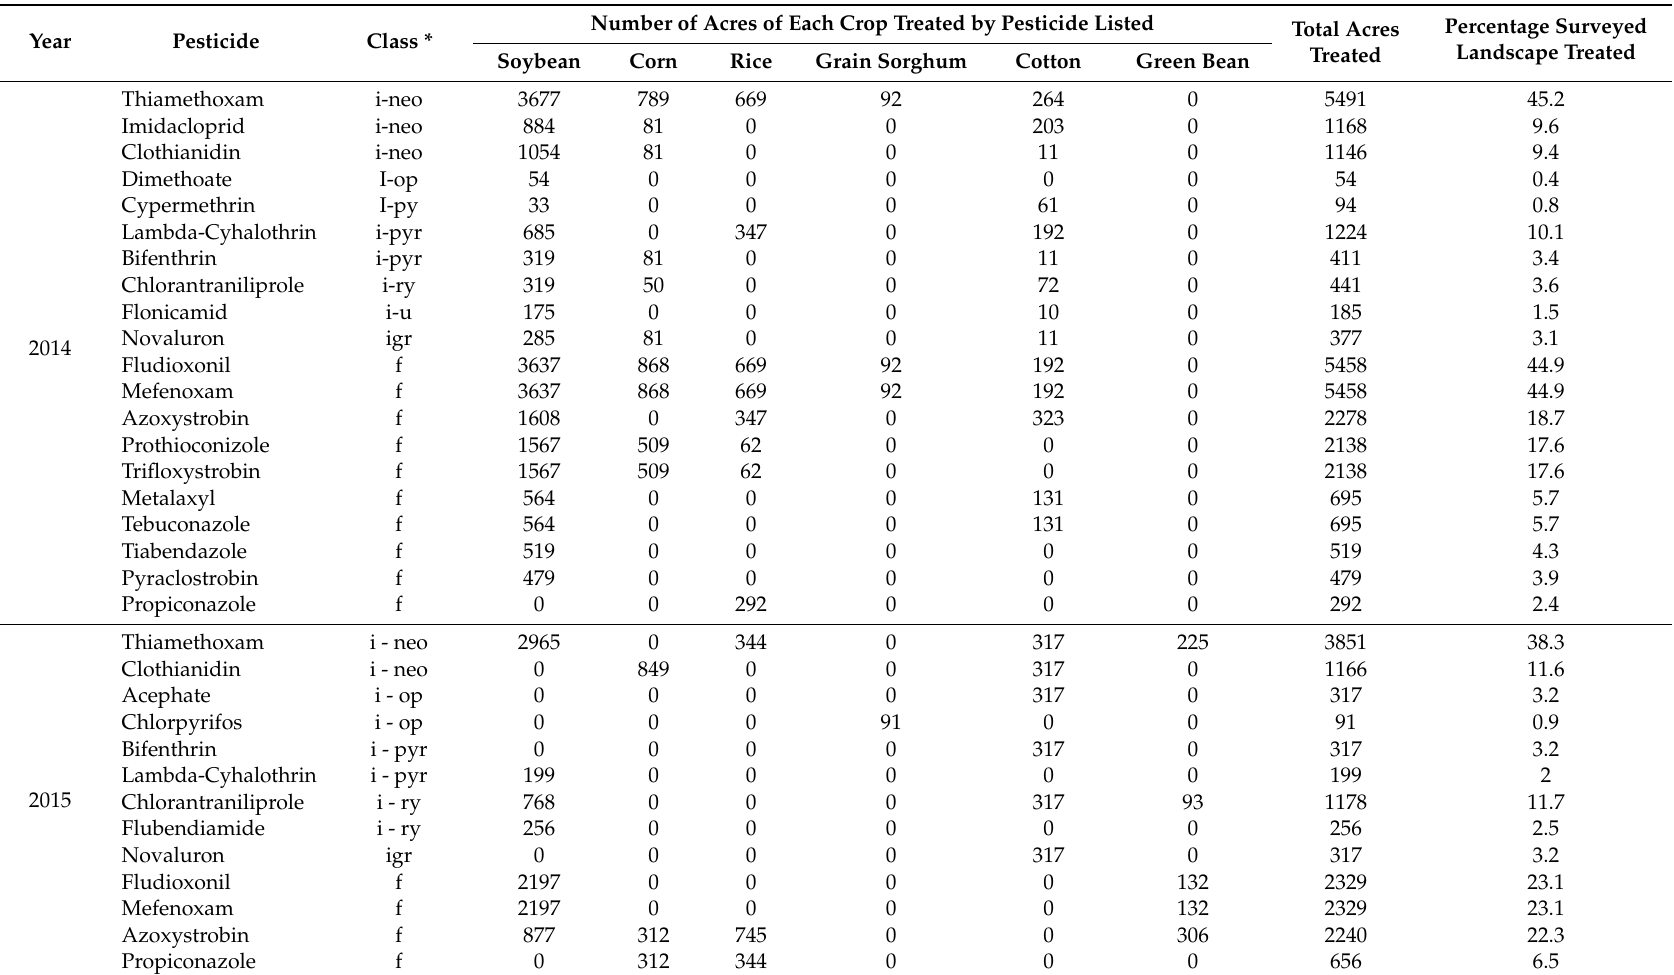
Table 2. Reported acreage receiving pesticide application, by crop, within the High-Ag survey area during the 2014 and 2015 growing